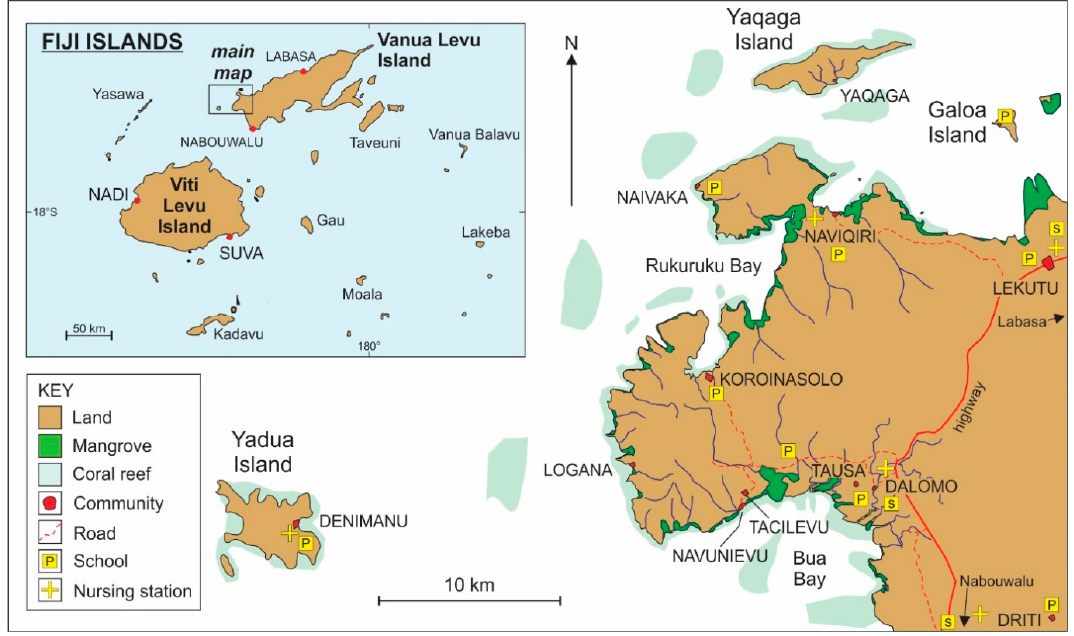
Figure 1. Map of the study area in and off western Vanua Levu Island, Fiji (Bua Province) showing the locations of the 13 communities studied together with infrastructure, reefs and mangroves, and key services (P is primary school, S is secondary (high) school). Inset map shows the location of the main map within the Fiji Islands.